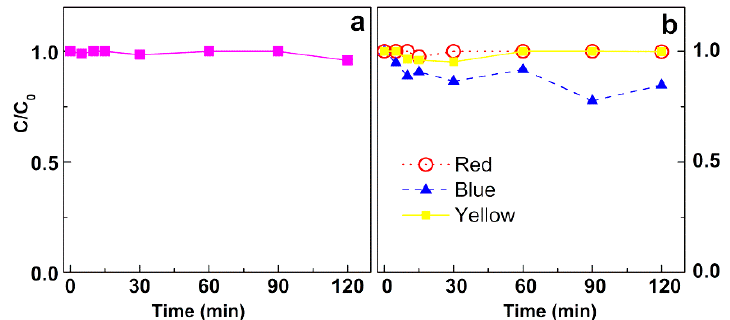
Figure 6. UV-Visible absorption spectra of aqueous solutions of ( a ) Rhodamine B (40 mg / L) and ( b ) industrial reactive dyes (80 mg / L). Red: C.I. Reactive Red 195; Blue: C.I. Reactive Blue 250; Yellow: C.I. Reactive Yellow 145.